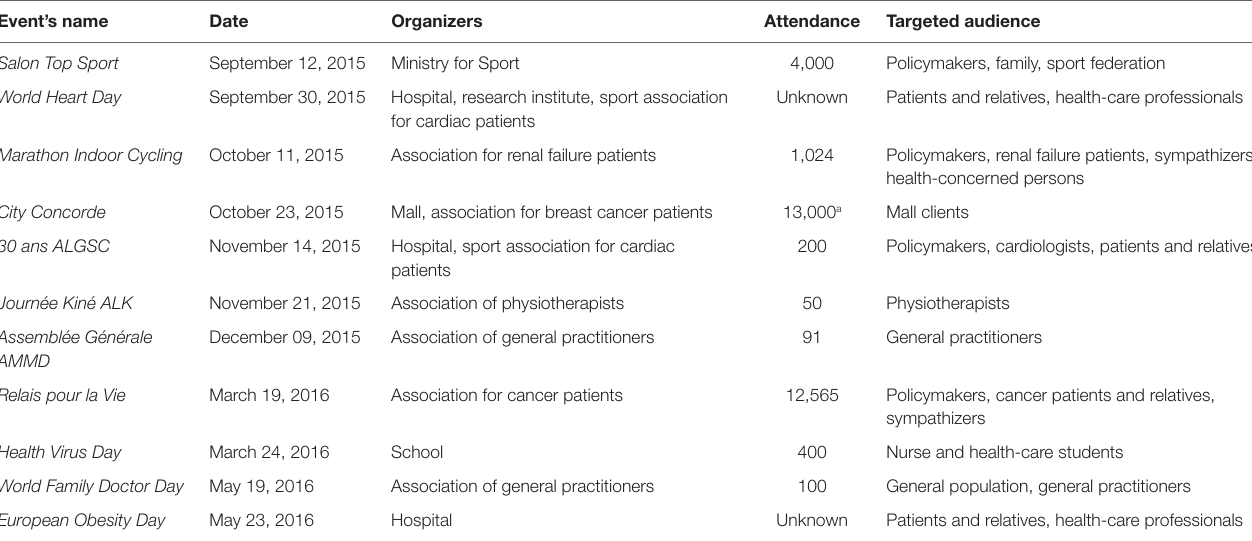
TaBle 1 | list of the booths aiming to promote sport-santé in